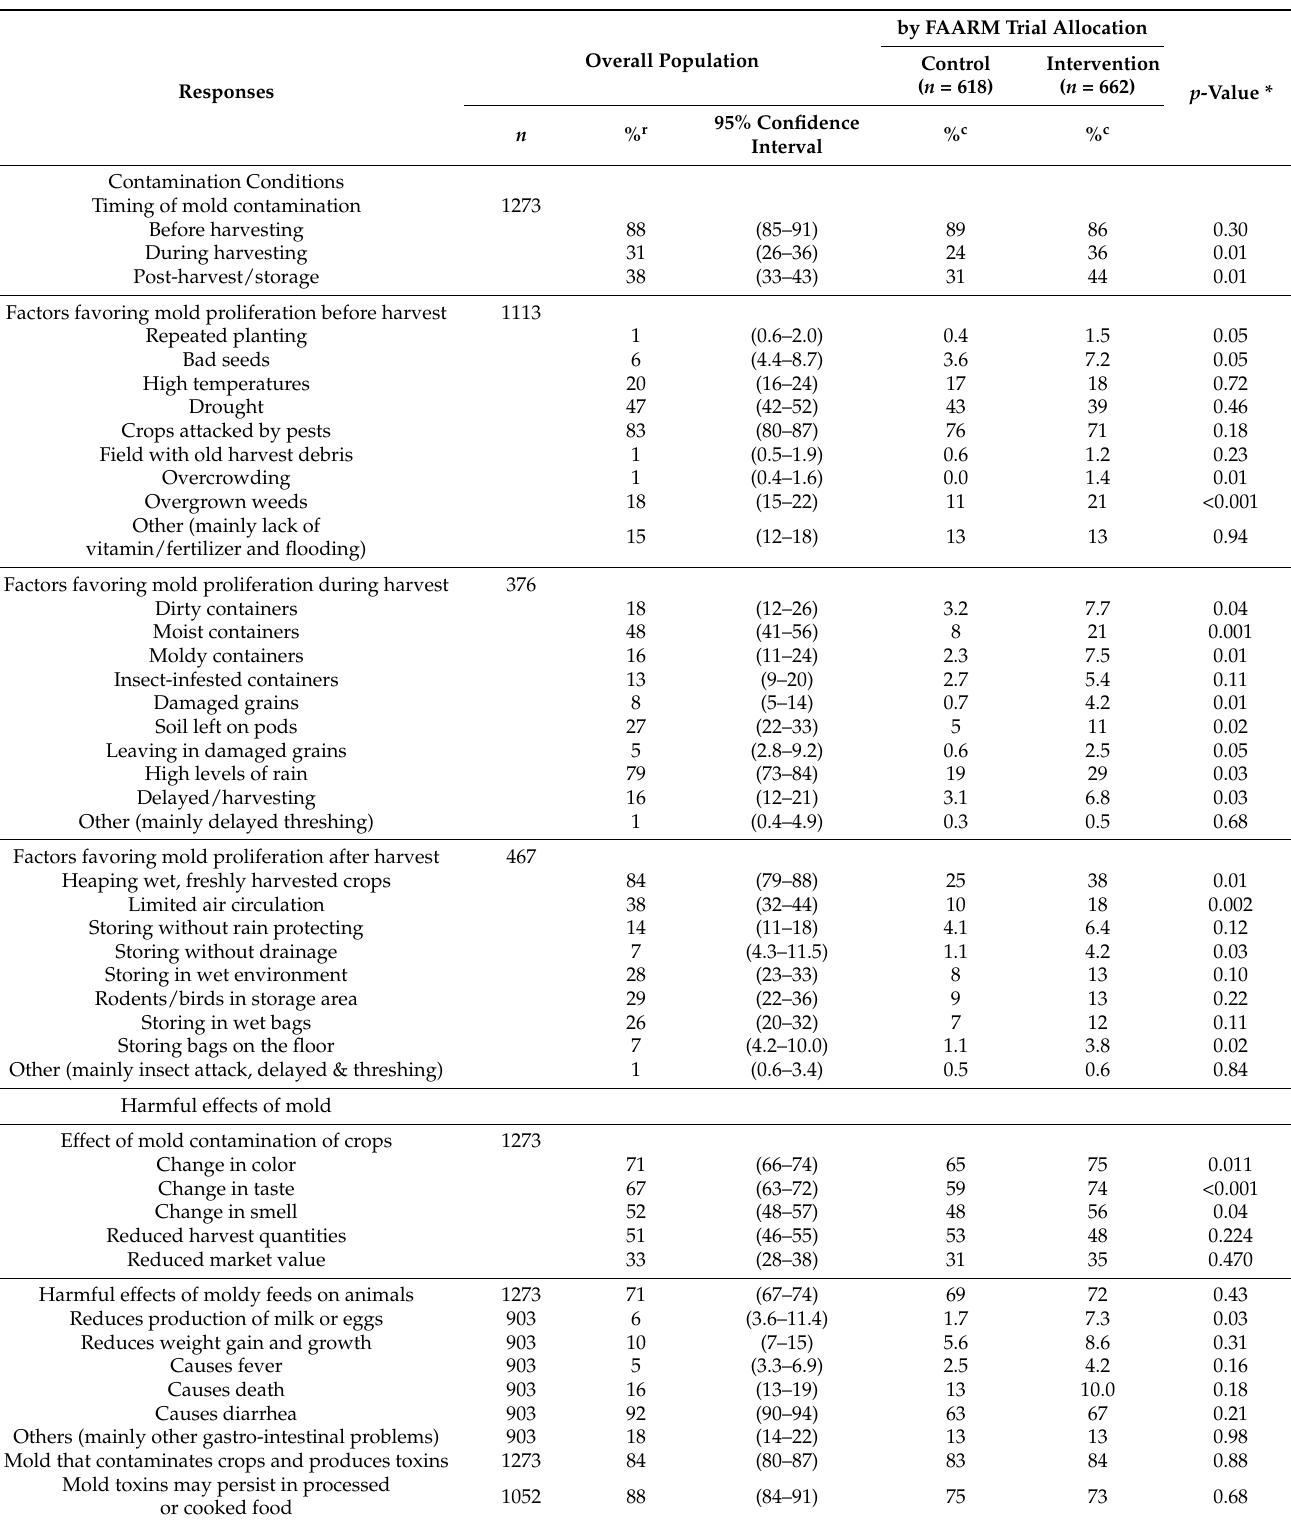
Table 4. Knowledge of contamination conditions, harmful effects, and preventive practices regarding mold and mycotoxin contamination of food